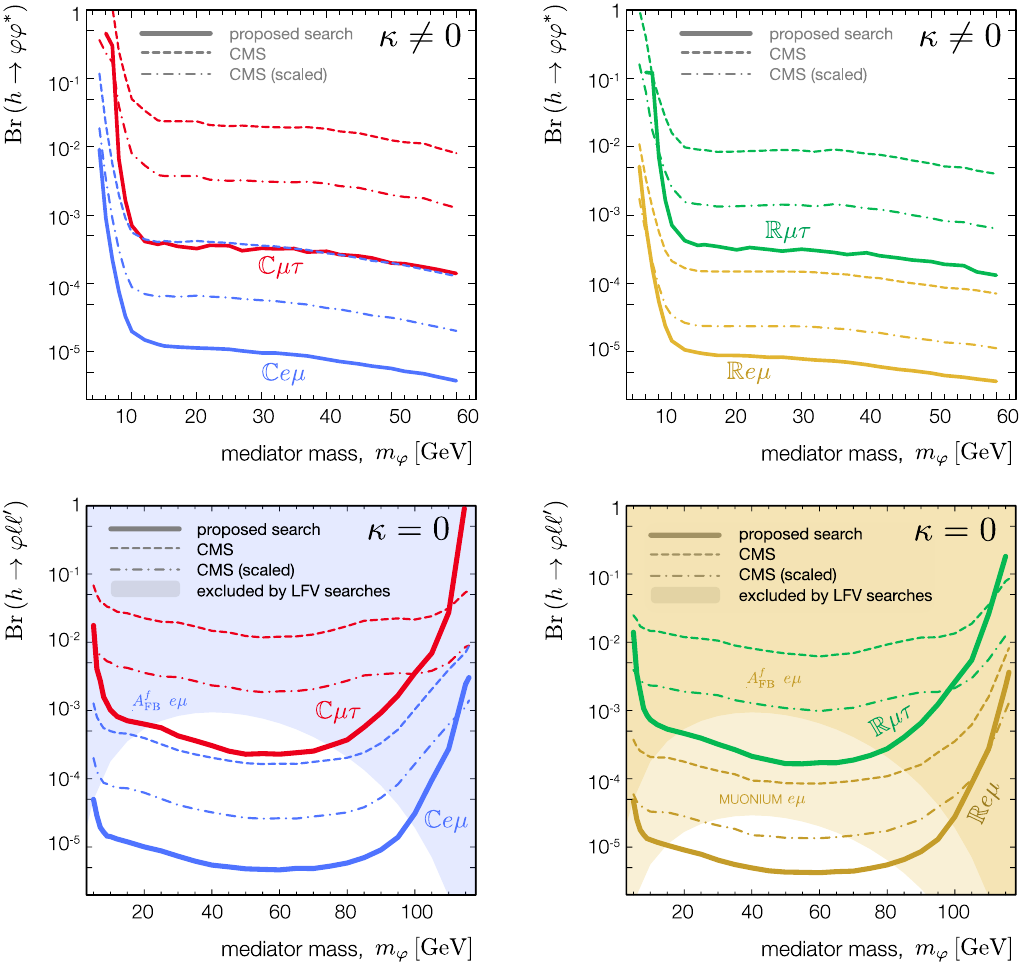
Figure 6 . Limits on the branching ratio at 95% cl for the models listed in table 1 in the case with a non-zero quartic coupling (cid:20) 6 = 0 ( top ), and a zero quartic coupling (cid:20) = 0 ( bottom ). The dashed curves are cms results at 8 TeV [53]. The dot-dashed curves are the same results scaled p using (4.15). The thick curves correspond to our search proposal at s = 13 TeV, and a luminosity of 150 fb (cid:0) 1 . The bottom two (cid:12)gures show the excluded region from the most relevant lepton-(cid:13)avor violating searches in the e(cid:22) cases. The (cid:22)(cid:28) cases are